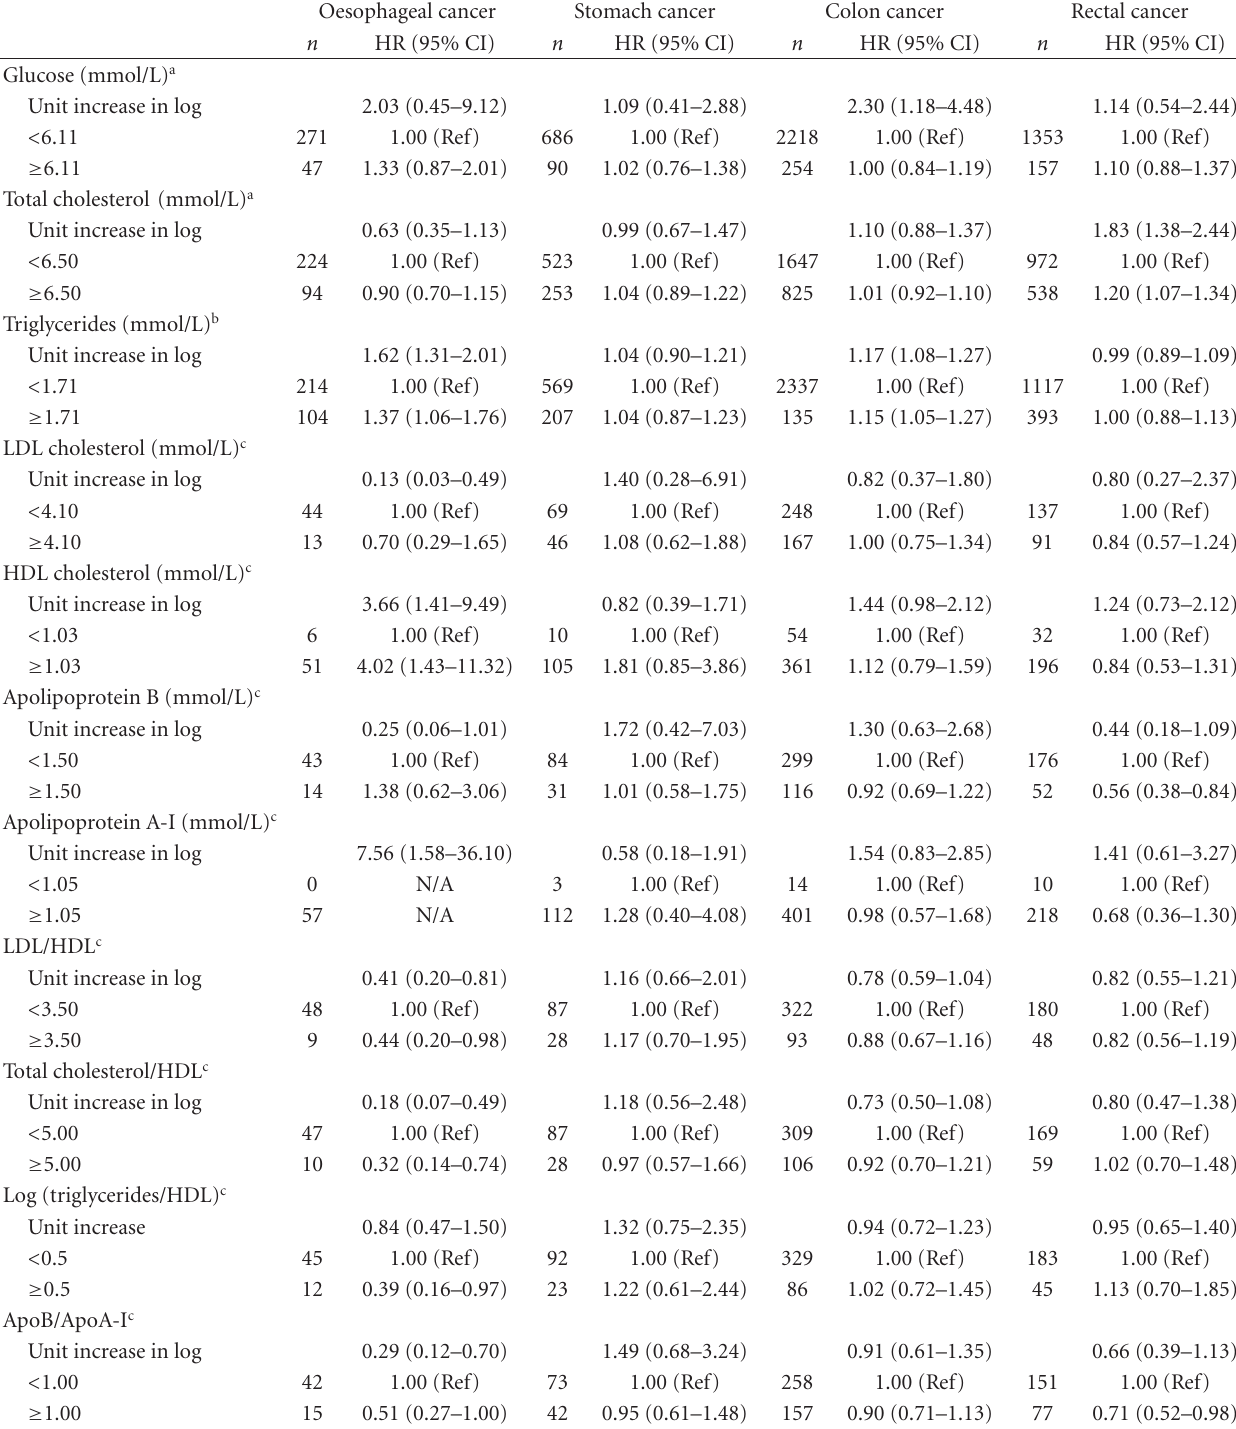
Table 3: Hazard ratios and 95% confidence intervals for GI cancer for lipid components as continuous variables and based on cut-o ff points used in cardiovascular disease prevention, adjusted for age, gender, SES, fasting status, glucose (continuous), total cholesterol (continuous), and triglycerides